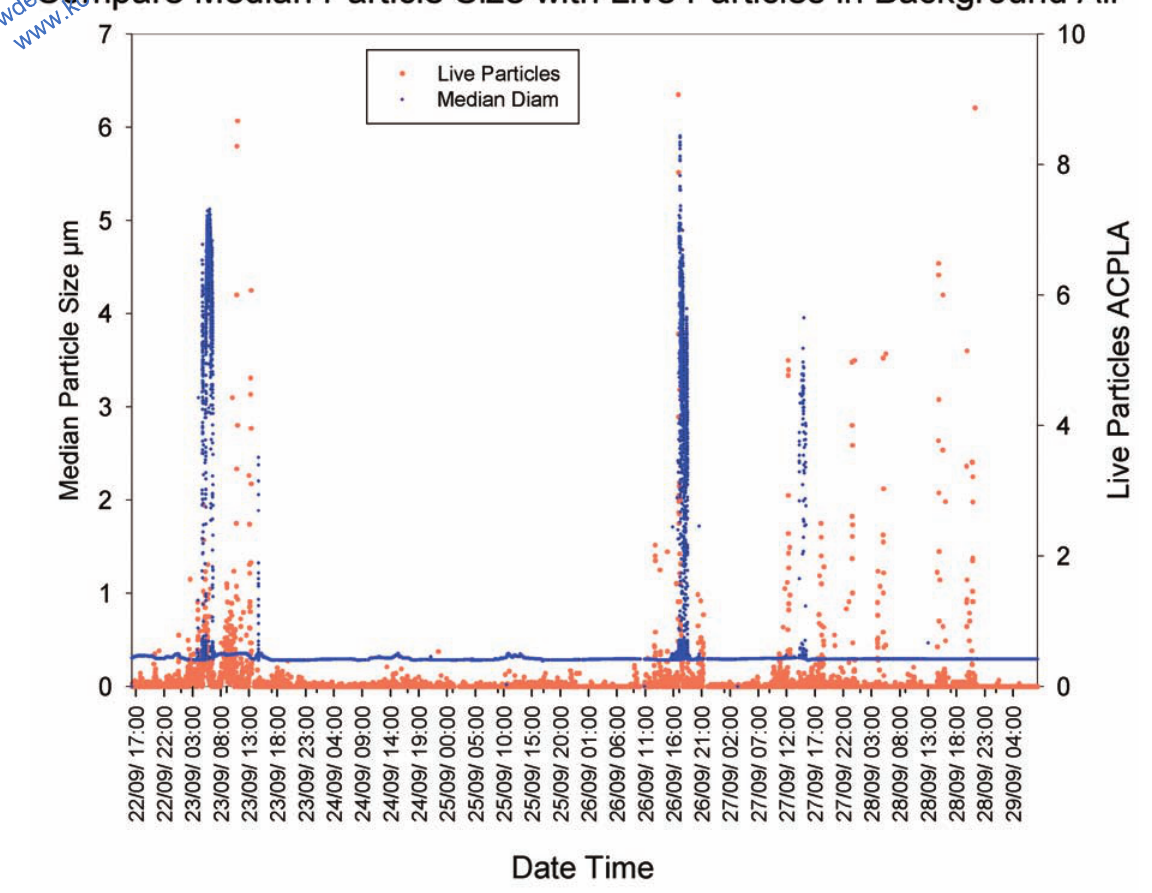
Fig. 7 Sampling background air over a one week period in Umea, Sweden. Live particles were measured using conven- tional slit impaction on growth agar while fluorescent particles were obtained with a FLAPS instrument. There were three major periods of thunderstorm accompanied by rain, depicted by the fluorescent signals (blue dots). The data show that when there were live bacterial particles present, the median particle size distribution also increased at about the same